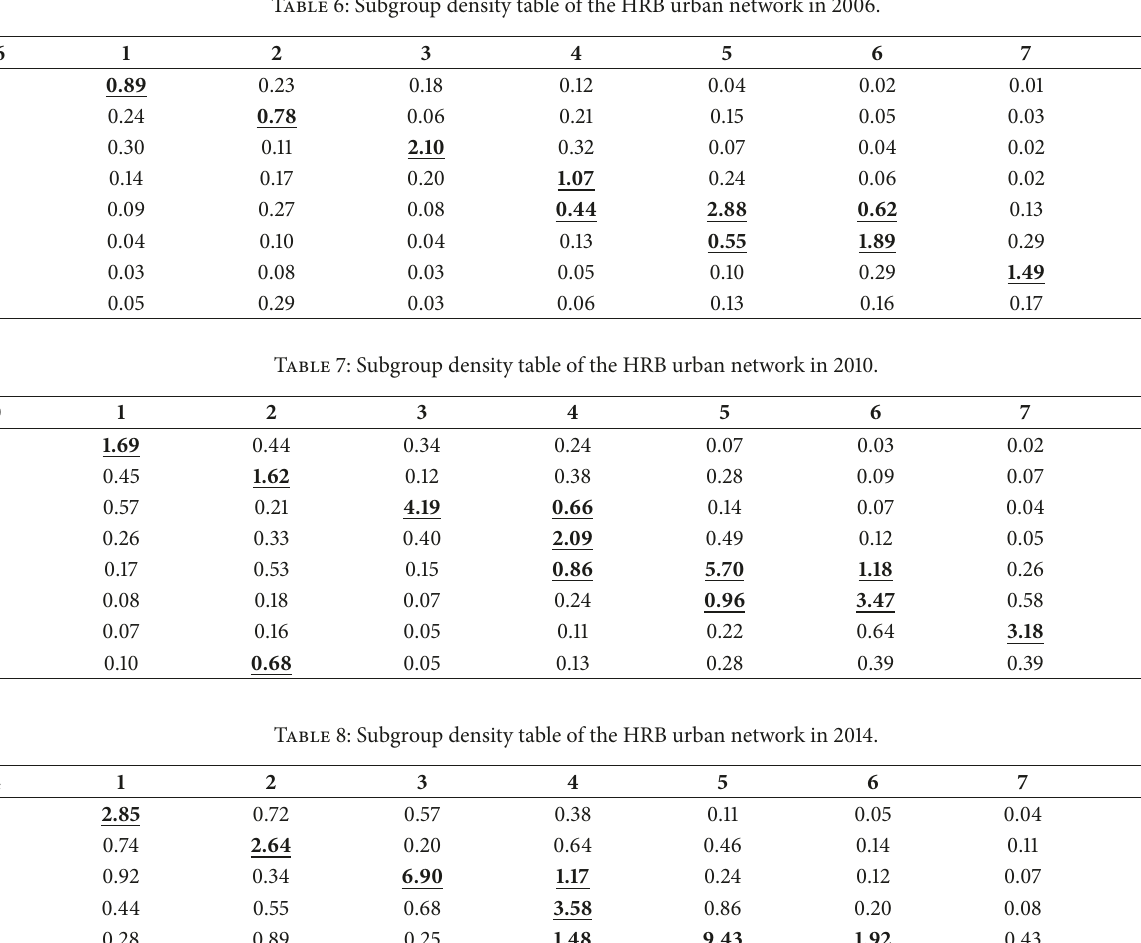
Table 6: Subgroup density table of the HRB urban network in 2006.